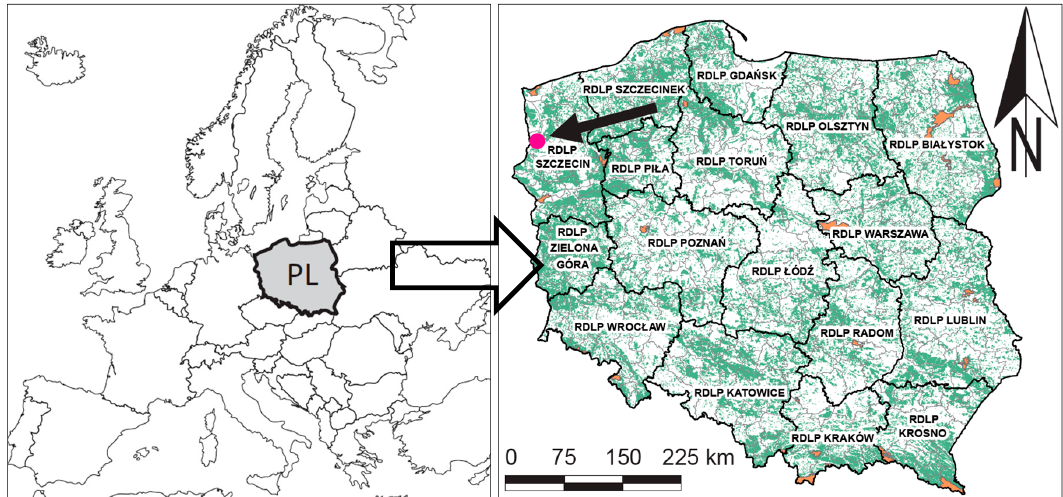
Figure 1. Location of the research area on the map of Poland with division into Regional Directorates of State Forests (RDLP).